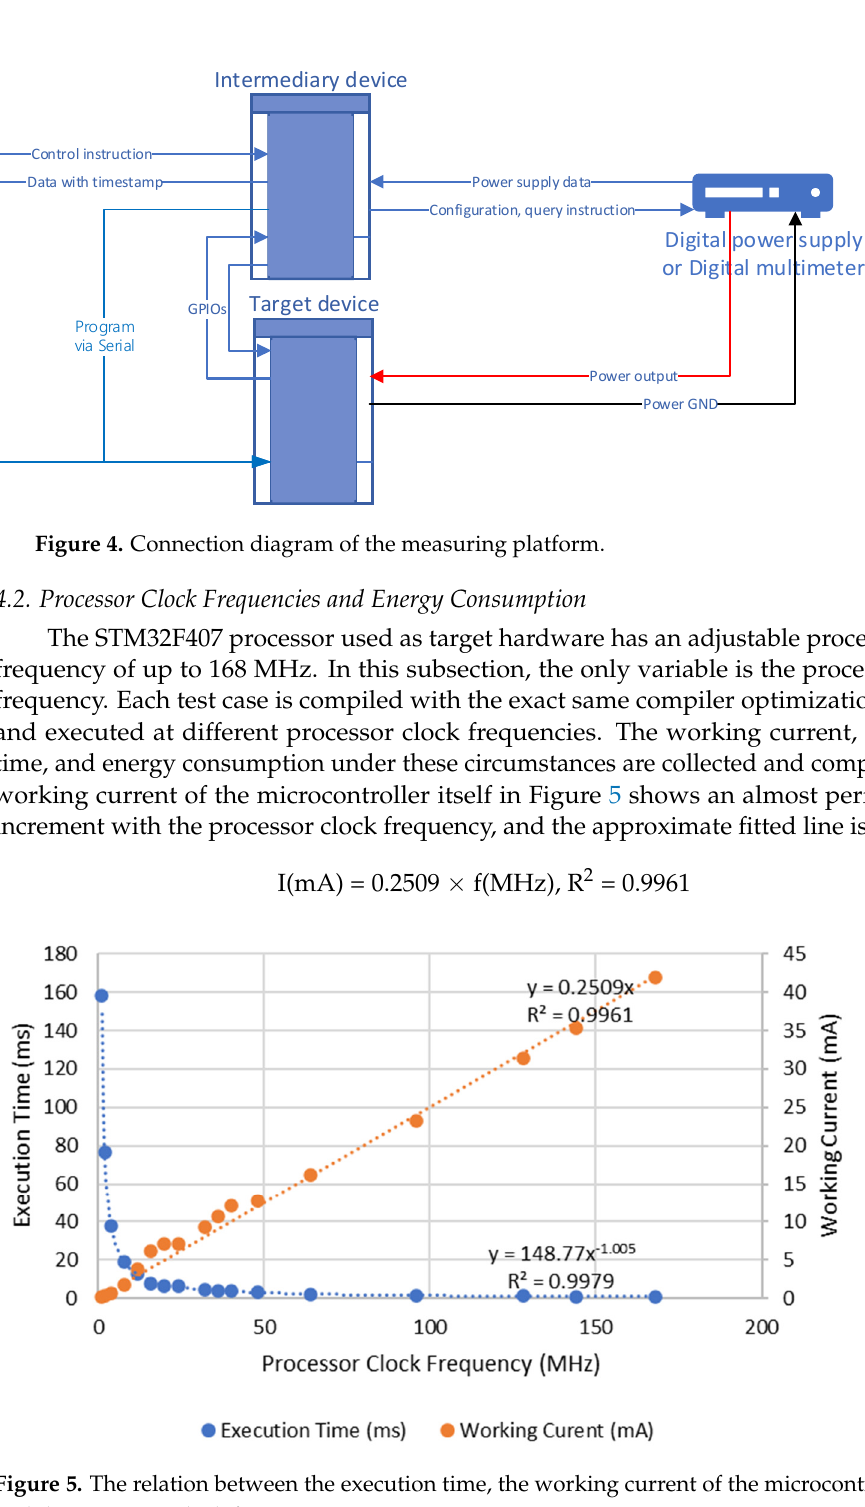
Figure 3. The measuring platform.